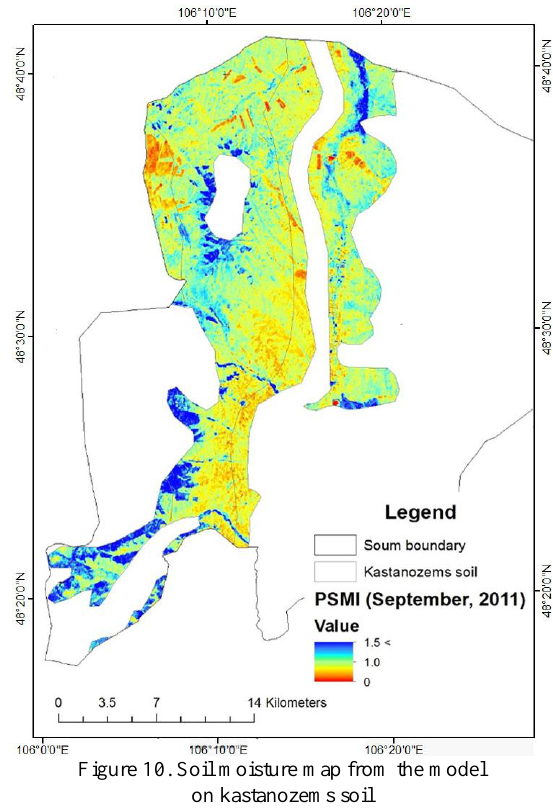
Figure 10. Soil moisture map from the model on kastanozems